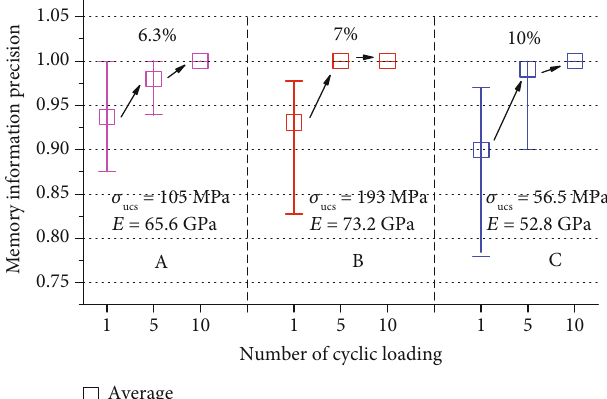
Figure 7: Typical DRA curves by di ff erent rocks and stress levels.